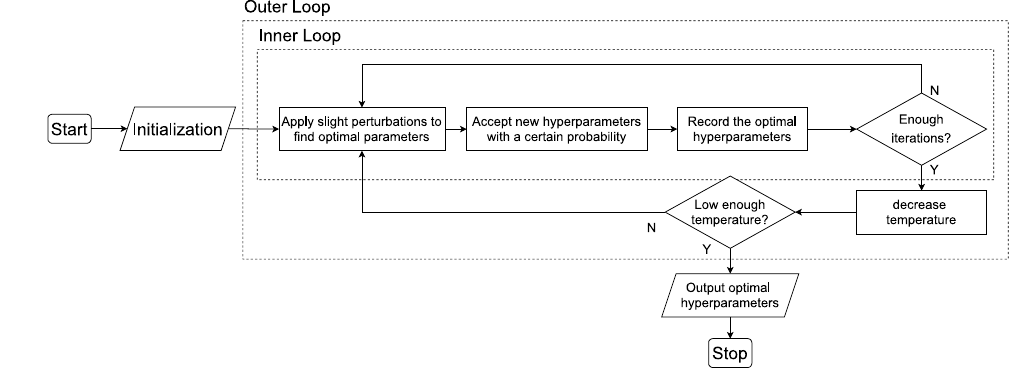
Figure 2. The basic block diagram of the Self-Adaptive Hyperparameter Optimization Algorithm, which contains two loops. In the inner loop, a slight perturbation is applied to the current hyperpa- rameters, which are accepted with a certain probability. In the outer loop, the temperature decreases from a high value to a pre-set stop temperature.